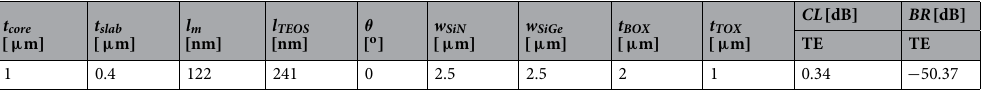
Table 4. Geometric parameters of the SiN-to-MQW interface. The values for the coupling loss and the back-reflection at the wavelength of 1310 nm are recorded investigating the fundamental TE case. The back- reflection value is related only to the fundamental mode.